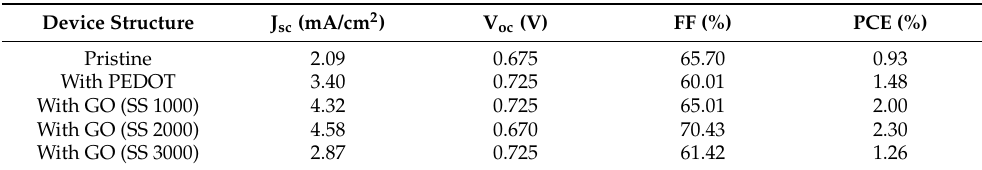
Table 1. Device’s parameters such as short circuit current density (J sc ), open circuit voltage (V oc ), fill factor (FF), and power conversion efficiency (PCE) without the hole transport buffer layer and with the hole transport buffer layer of PEDOT: PSS (or GO).